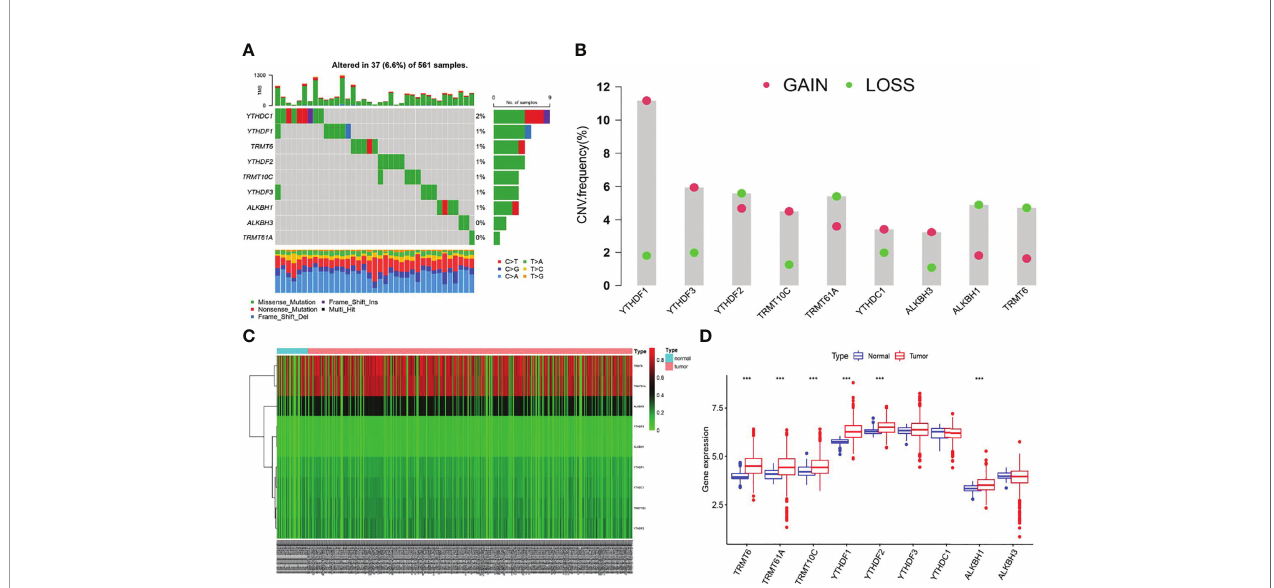
FIGURE 1 | The multi-omic landscapes of nine m1A regulators in LUAD. (A) Somatic mutations of nine m1A regulators in TCGA-LUAD. (B) The CNV features of m1A regulators in TCGA-LUAD. (C) DNA methylation levels of nine m1A regulators in TCGA-LUAD and normal patients (Tumor: 563; Normal: 53). (D) Gene expression levels of nine m1A regulators in TCGA-LUAD and normal patients (***P <